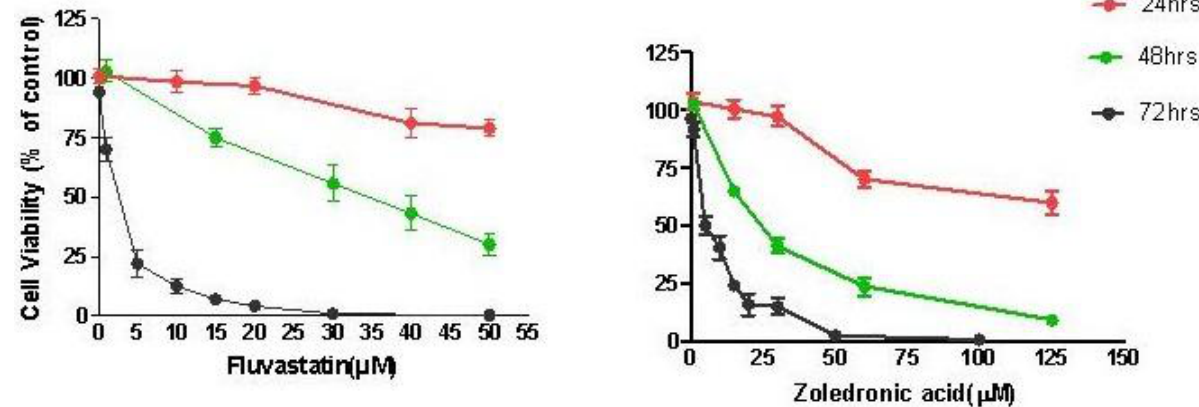
Figure 1. In vitro cytotoxicity of Fluvastatin and Zoledronic acid. T24 cells were exposed to a range of concentrations of fluvastatin (0.1 to 50  M) and zoledronic acid (0.1 to 125  M) for 24 to 72 hours as indicated, control cells treated identically except without adding drugs, the percentage of alive cells were detected by SRB method. The cytotocxicity of both drugs appeared dose and time dependant, T24 cells are slightly more sensitive to fluvastatin than to zoledronic acid, with an IC of 2.67 ± 0.61  M for fluvastatin and 50 5.35 ± 1.35  M for zoledronic acid at 72 hours treatment. Data represent the mean ± SD from three separate